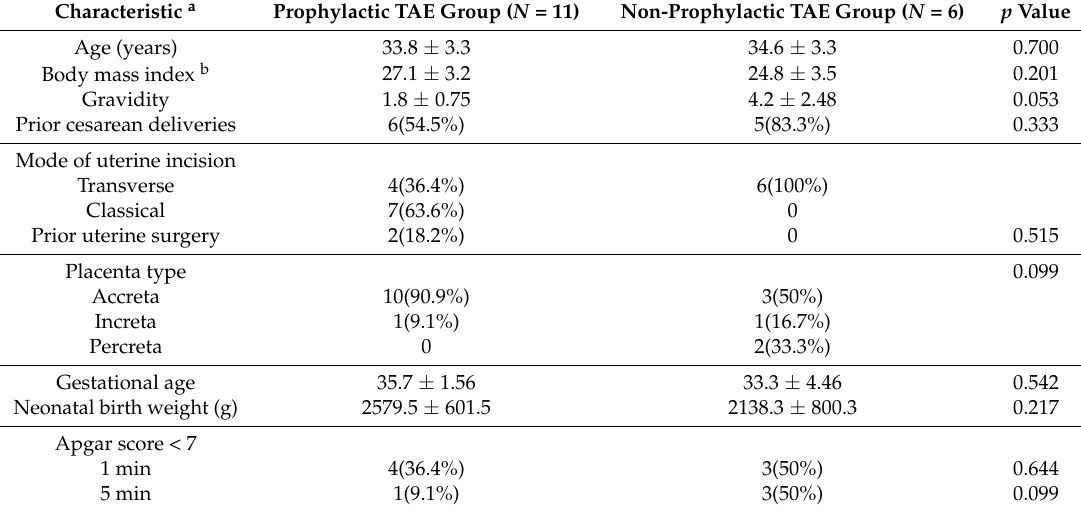
Table 1. Patient Characteristics.